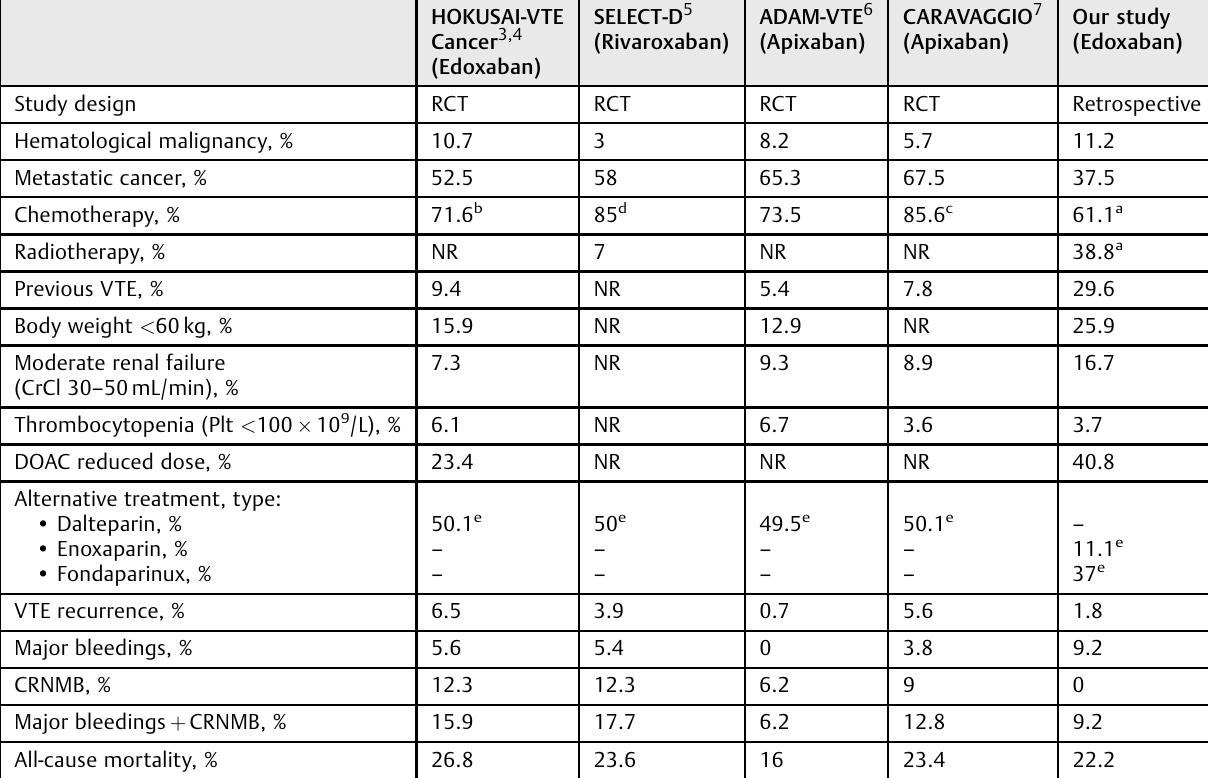
Table 3 Comparison of patients characteristics and 6-month outcomes between our study and the main randomized controlled clinical trials of DOACs for treatment of cancer-associated